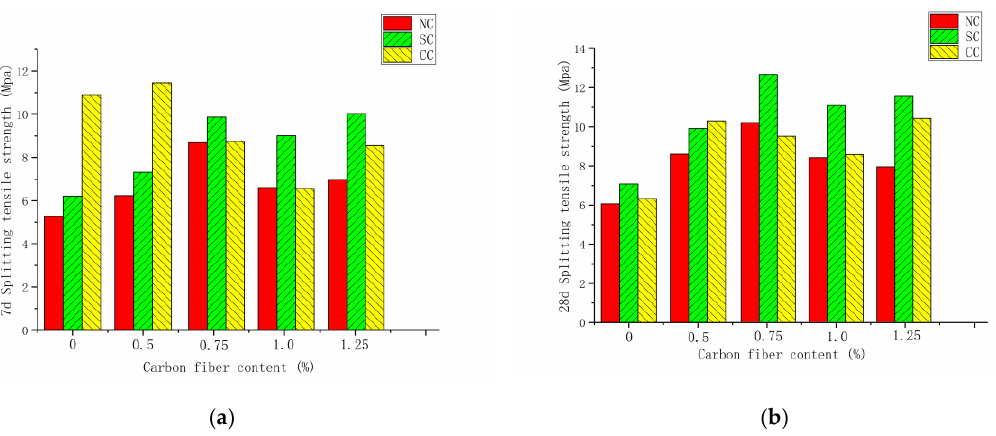
Figure 7. Splitting tensile strength under different curing systems at seven days and 28 days: ( a ) seven days, ( b ) 28 days.